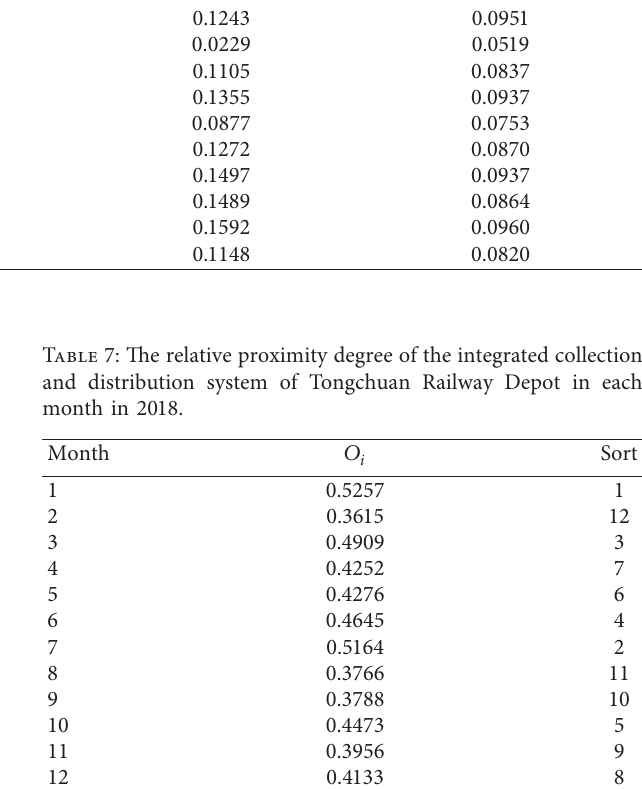
Table 5: The results of the multiple coupling development degree D Month